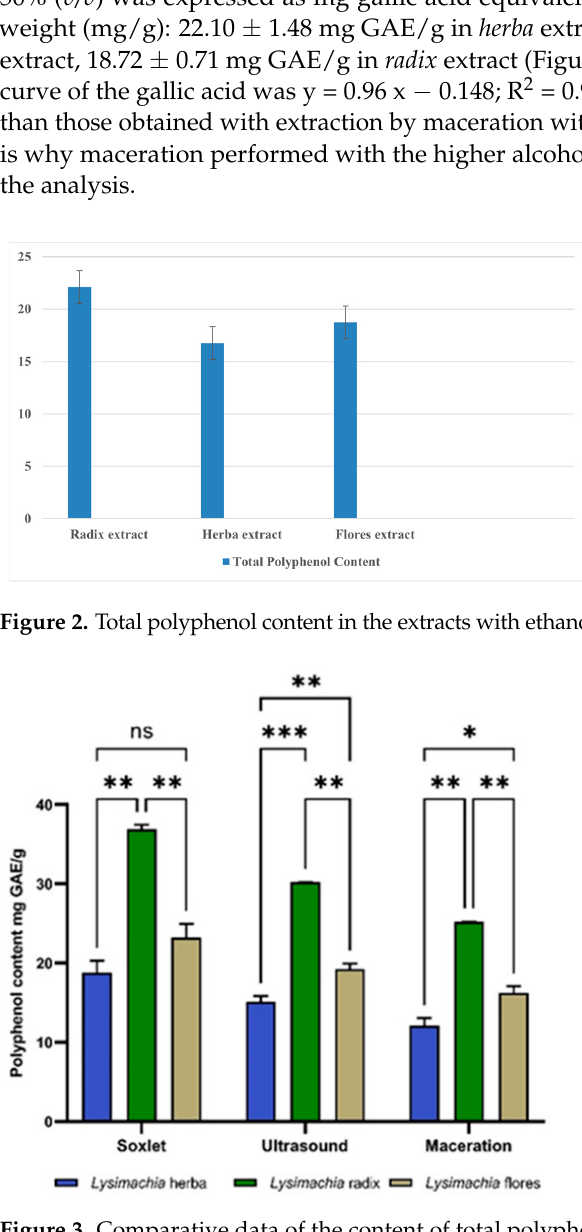
Figure 3. Comparative data of the content of total polyphenols obtained by the 3 extraction methods for Lysimachia herba, radix and flores extracts, with ethanol 70% ( v/v ). Results are indicated as mean ± SD of data ( n = 3). Asterisks indicate statistical significance examined by ANOVA with Tukey post hoc test for multiple reciprocal comparison among the extracts (significant: * p < 0.05, ** p < 0.01, *** p < 0.001; not significant (ns): p > 0.05).